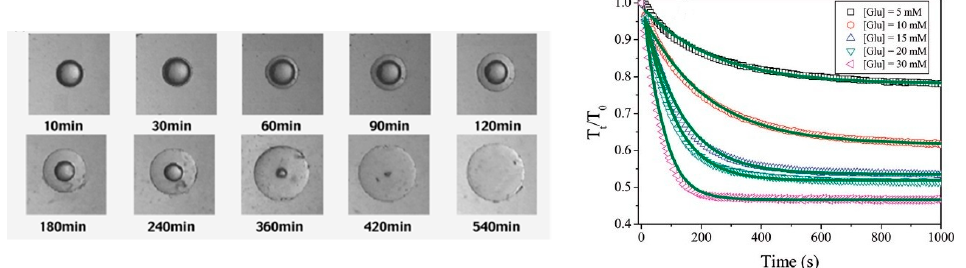
Figure 2. ( Left ) Images of swelling behavior of a P(NIPAAm- co -mAPBA) macrogel over time in the presence of 5 g/L D-Glu solution in pH 9 CHES buffer (T = 25 °C) [12]. Copyright 2004 American Chemical Society. ( Right ) Relative turbidity of P(NIPAAm -co-m APBA) microgel dispersion changes in function of time upon addition of D-Glu in 0.020 M pH 8.5 phosphate buffer (T = 25 °C) [13]. Copyright 2011 American Chemical Society.